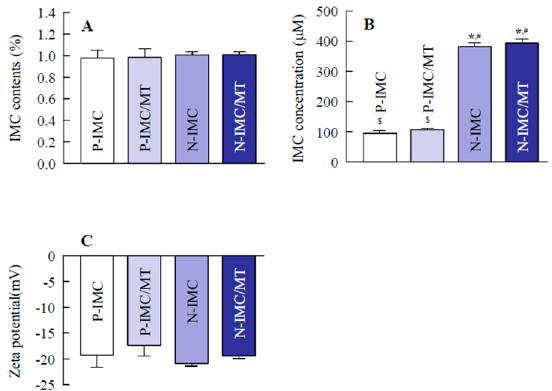
Figure 2. The stability and particle characterization of N-IMC and N-IMC/MT gels. ( A ); the dispersity in the base of IMC transdermal formulations. ( B ); the solubility of IMC in transdermal formulations. ( C ); the zeta potential of IMC in transdermal formulations. n = 6–8. * p < 0.05 vs. P-IMC gel for each category. # p < 0.05 vs. P-IMC/MT gel for each category. $ p < 0.05 vs. N-IMC gel for each category. Almost all IMC was in the solid state in the IMC transdermal formulations (ratio, solid form: solution form = 98.6: 1.4), and the drug homogeneity (dispersity, standard error) in the solid nanoparticles (SNPs)-based transdermal formulations was higher than in the microparticles-based transdermal formulations. The zeta potentials of the IMC transdermal formulations with or without l-menthol were similar, and the IMC contents in the microparticles-and SNPs-based transdermal formulations did not change for 1 month.